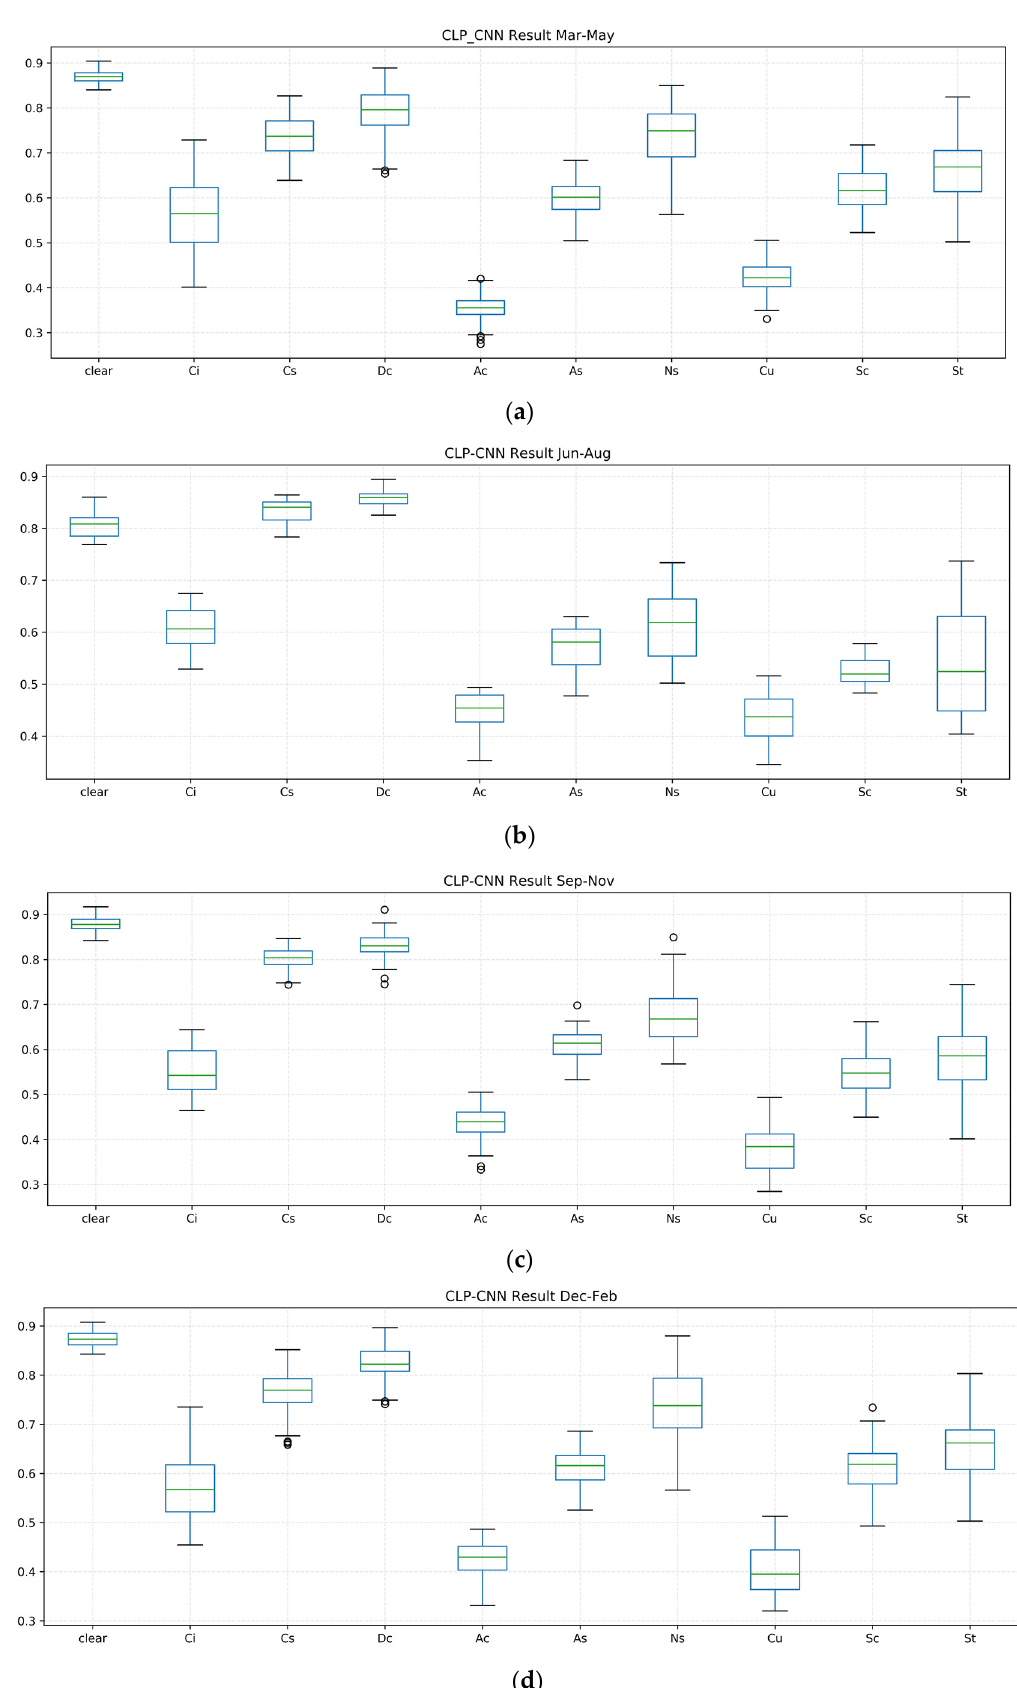
Figure 11. Results of the classification evaluation for the different seasons. Based on the statistical results of the seasonal evaluation, the different cloud types are strongly influenced by their distribution characteristics. The results of the middle-level and high-level cloud classifications showed high robustness throughout the year. How- ever, there were some fluctuations in the correct rate of low-level and middle-level clouds over the seasons. For example, the St cloud type has a high POD score in March–May, but in June–August, the St distribution decreases significantly compared with March–May, its POD score decreases, and its accuracy fluctuates from time to time. In the December–Feb- ruary period, the St distribution share improved by 54%. Therefore, there was a further increase in POD. The statistics on the percentage of cloud types also showed that the per- centage of different types of clouds showed a significant change in different seasons. Therefore, the seasons had some influence on the accuracy of the classification results of the CLP-CNN network. The Ci, AC, and Cu cloud types are thin in optical thickness compared with the other cloud types in the ISCCP cloud classification standard. The distribution of the three types of clouds is also more dispersed compared with the other types of clouds, and they present a greater challenge to the cloud classification model. All three types of clouds do not give similar results relative to other cloud types of similar cloud top heights. In contrast, the Clear Sky, St, NS, and Dc types have a larger proportion of cloud types, while they are generally located in the center of the cloud mass and are more continuous in their distri- bution, thus achieving a higher percentage of accuracy. The Ci, AC, and Cu types of clouds are generally distributed at the edge of the cloud cluster, the distribution is discontinuous and fragmented, and their proportion is lower than other types of clouds. This leads to their low proportion in the training samples, and there is a serious problem of an uneven distribution of samples. In addition, parallax errors of geostationary satellites also affect the classification accuracy of these thin clouds. These reasons have caused the cloud clas- sification accuracy to be below expectations of the more effective evaluation accuracy of the CLP-CNN network output. The errors are not only from the FY-4A satellite observa- tions but also from the Himawari-8 satellite. In order to better verify the accuracy of cloud classification results of the CLP-CNN network, we used CloudSat data for evaluation in Section 4.4. 4.4. CloudSat In this section, 2B-CLDCLASS data from the Cloudsat satellite were used to evaluate the results. With the CPR radar on board, the CloudSat satellite can accurately determine the type of clouds in the cloud layer below. We use the CloudSat classification results to better evaluate the accuracy of the CLP-CNN cloud classification results. The output of the CLP-CNN network and the Himawari-8 product were matched to the CloudSat data